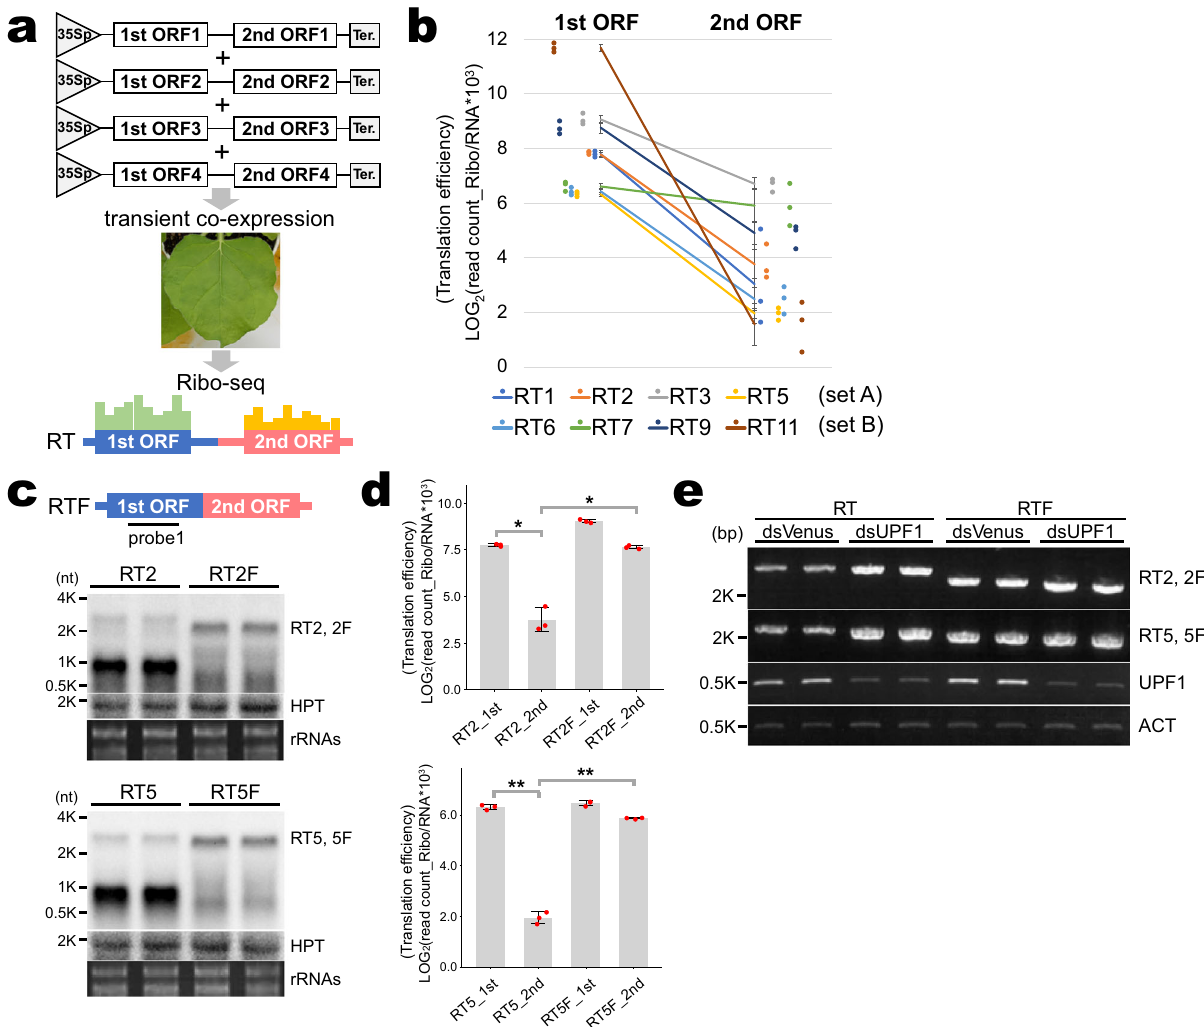
Fig. 3 Survey for the relationship between translation and NMD. a Methodology for transient expression assay. Four RTs were transiently expressed at the same time and analyzed by Ribo-seq. b Comparison of translation ef fi ciency between the fi rst and second open reading frames (ORFs). Set A (RT1, RT2, RT3, and RT5) and Set B (RT6, RT7, RT9, and RT11) were tested separately. n = 3 biologically independent samples. Individual data points are shown on the left ( fi rst ORF) and right (second ORF) sides of the graph. Error bars show the standard deviation. c Northern blot analysis for the detection of RT2, RT2F, RT5, and RT5F. Total RNAs were extracted from Nicotiana benthamiana leaves at 3 days after in fi ltration. HPT (hygromycin phosphotransferase) was also detected as a loading control. The HPT gene was on the same expression vector as the RTs and RTFs. n = 2 biologically independent samples. d Translation ef fi ciency of the fi rst (1st) and second (2nd) ORFs of RT2 and RT2F (upper panel), and RT5 and RT5F (lower panel). n = 3 biologically independent samples. Asterisks indicate signi fi cant differences (Tukey ’ s test; * P < 10 − 5 , ** P < 10 − 6 ). Individual data points are shown as red dots. Error bars show the standard deviation. e RT-PCR analysis for the detection of RT2, RT2F, RT5 and RT5F in a transient RNAi assay. RTs and RTFs were co-expressed with either dsUPF1 or dsVenus. Total RNA was extracted from Nicotiana benthamiana leaves at 6 days after in fi ltration. NbACT expression was used as a loading control. n = 2 biologically independent